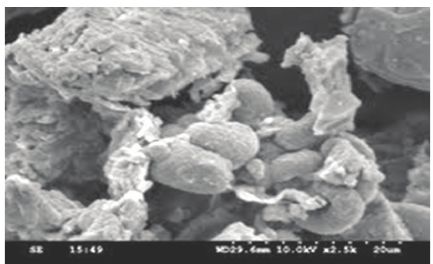
Figure 4: Scanning electron microscopic photograph of AB25 loaded IJSP.